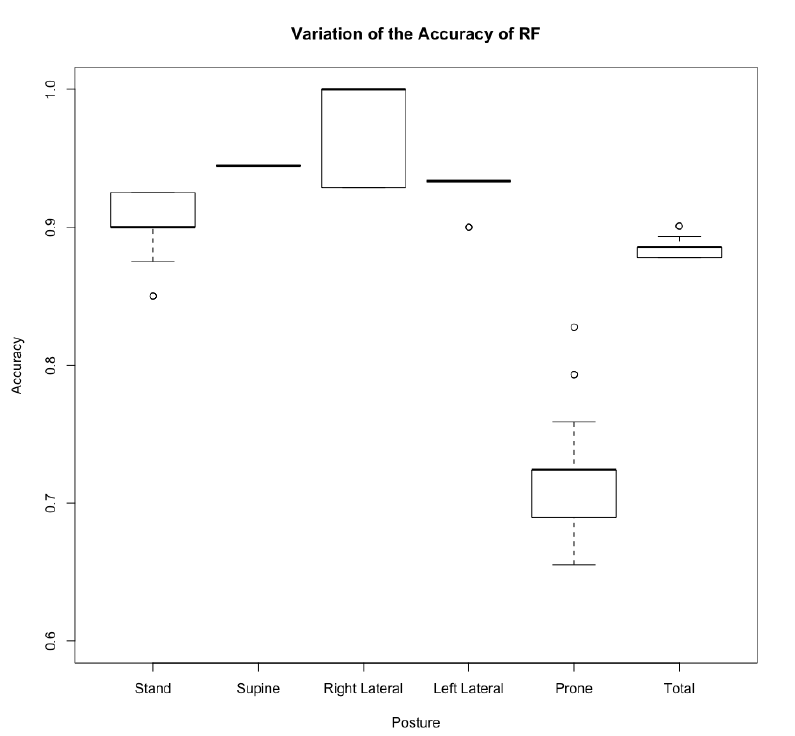
Figure 12. Statistic result for RF model. The boxes represent the 25 percentile and the 75 percentile. The bold horizontal lines represent the mean. The dots represent the outliers.